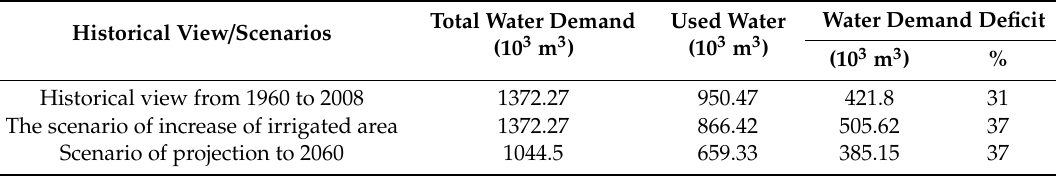
Table 7. The average annual quantity of used water and the water demand deficit (for domestic consumption) simulated in the Sabor River Basin for the historical view (1960–2008), and for the two scenarios (an increase in the irrigated area and the projection to 2060). The scenario of an increase in the irrigated area represents the irrigation of the total irrigable area identified in Continental Portugal for 2007 (COS2007) [21].